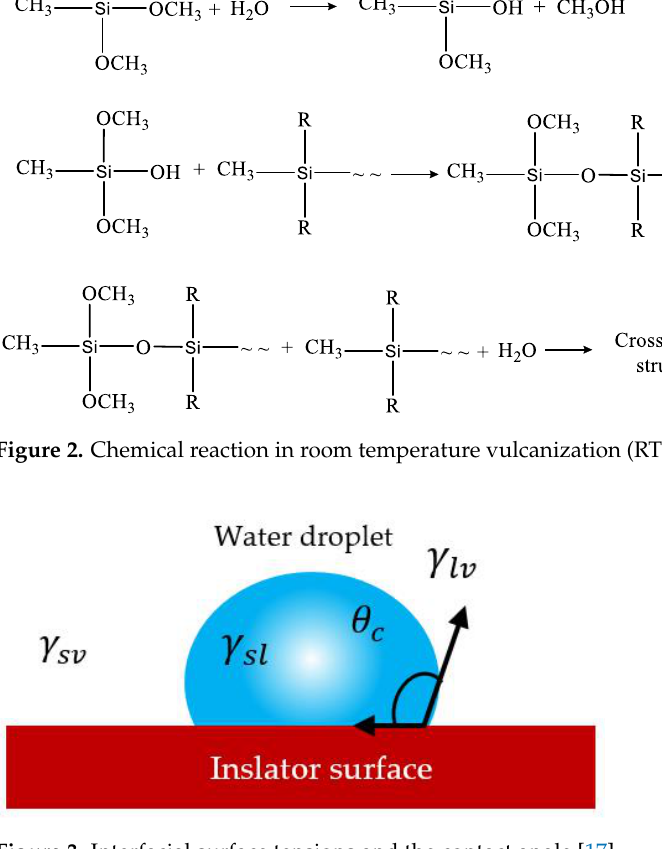
Figure 2. Chemical reaction in room temperature vulcanization (RTV) [16].